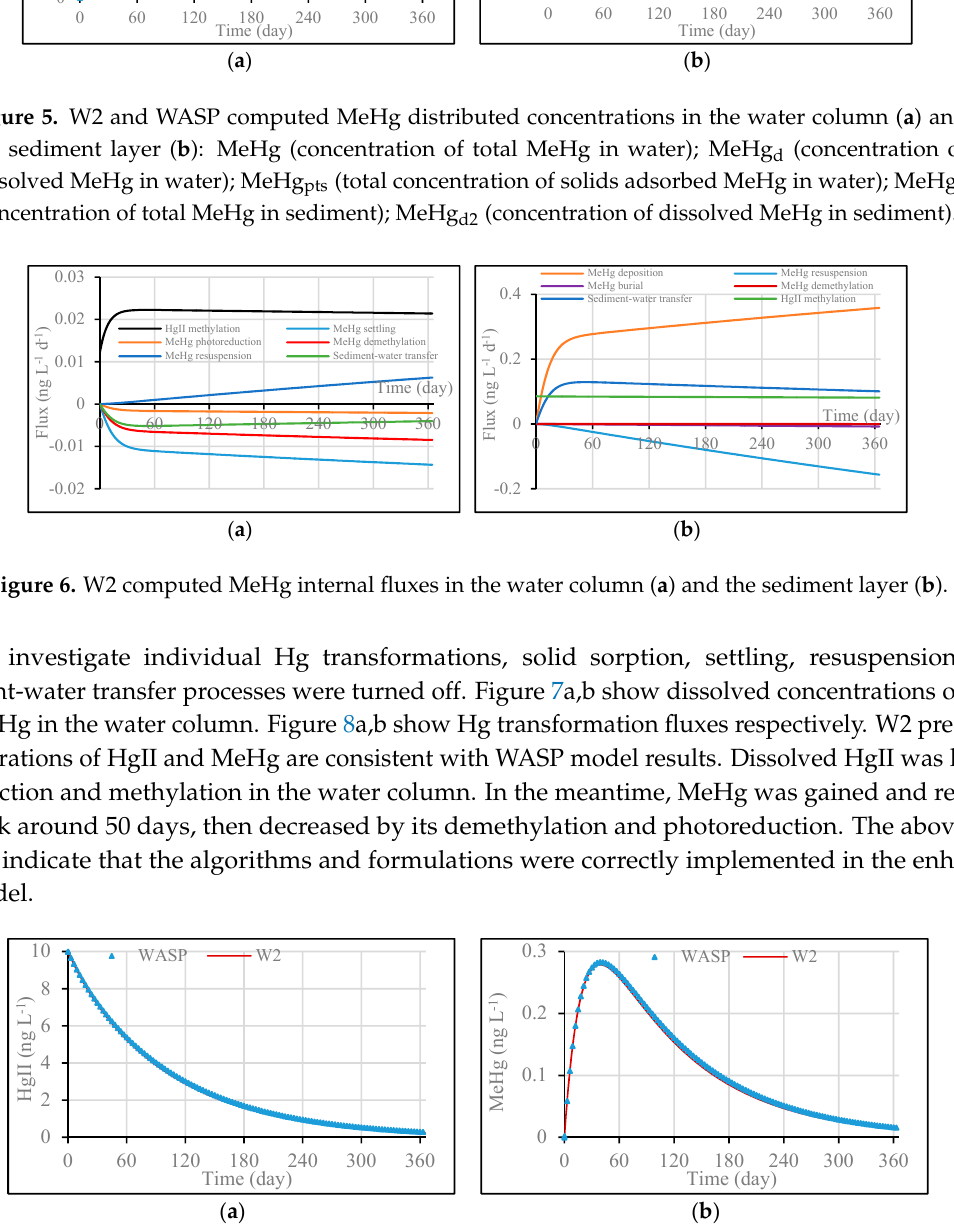
Figure 7. W2 and WASP computed ( a ) HgII and ( b ) MeHg concentrations in the water column.